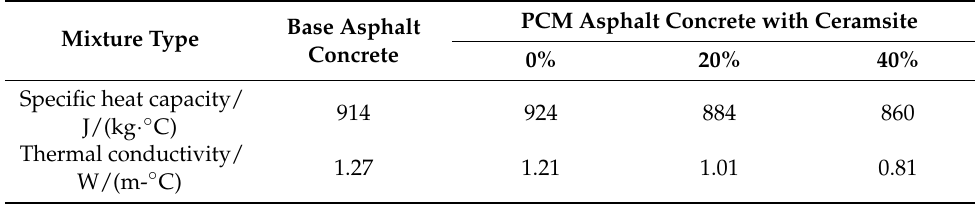
Table 5. Thermophysical property of different kinds of asphalt